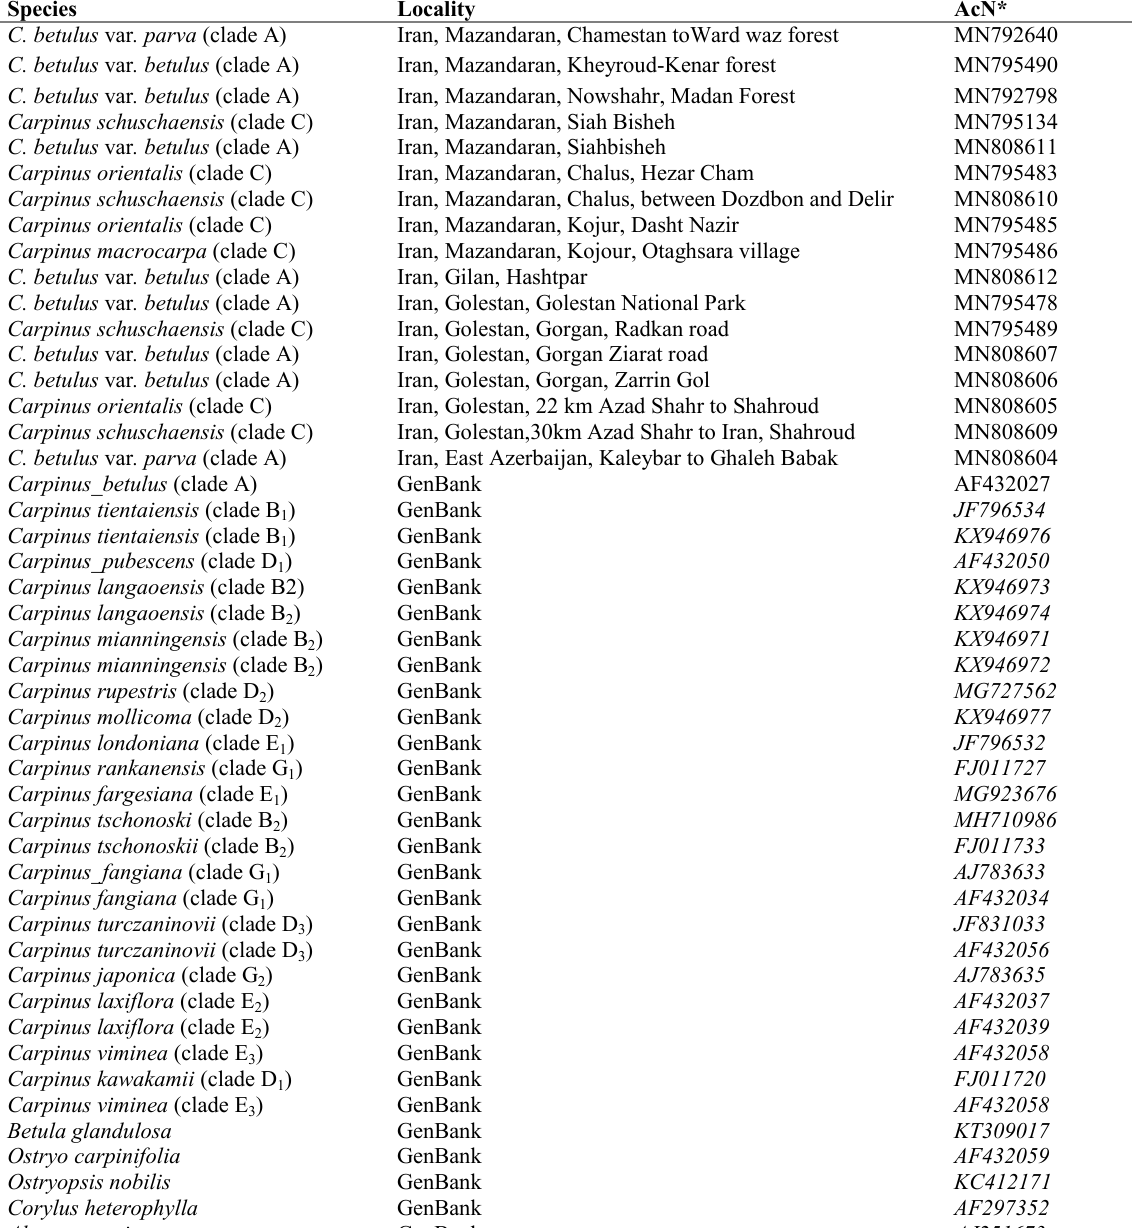
Table 4 . Species with clade affiliation , location, and GenBank accession